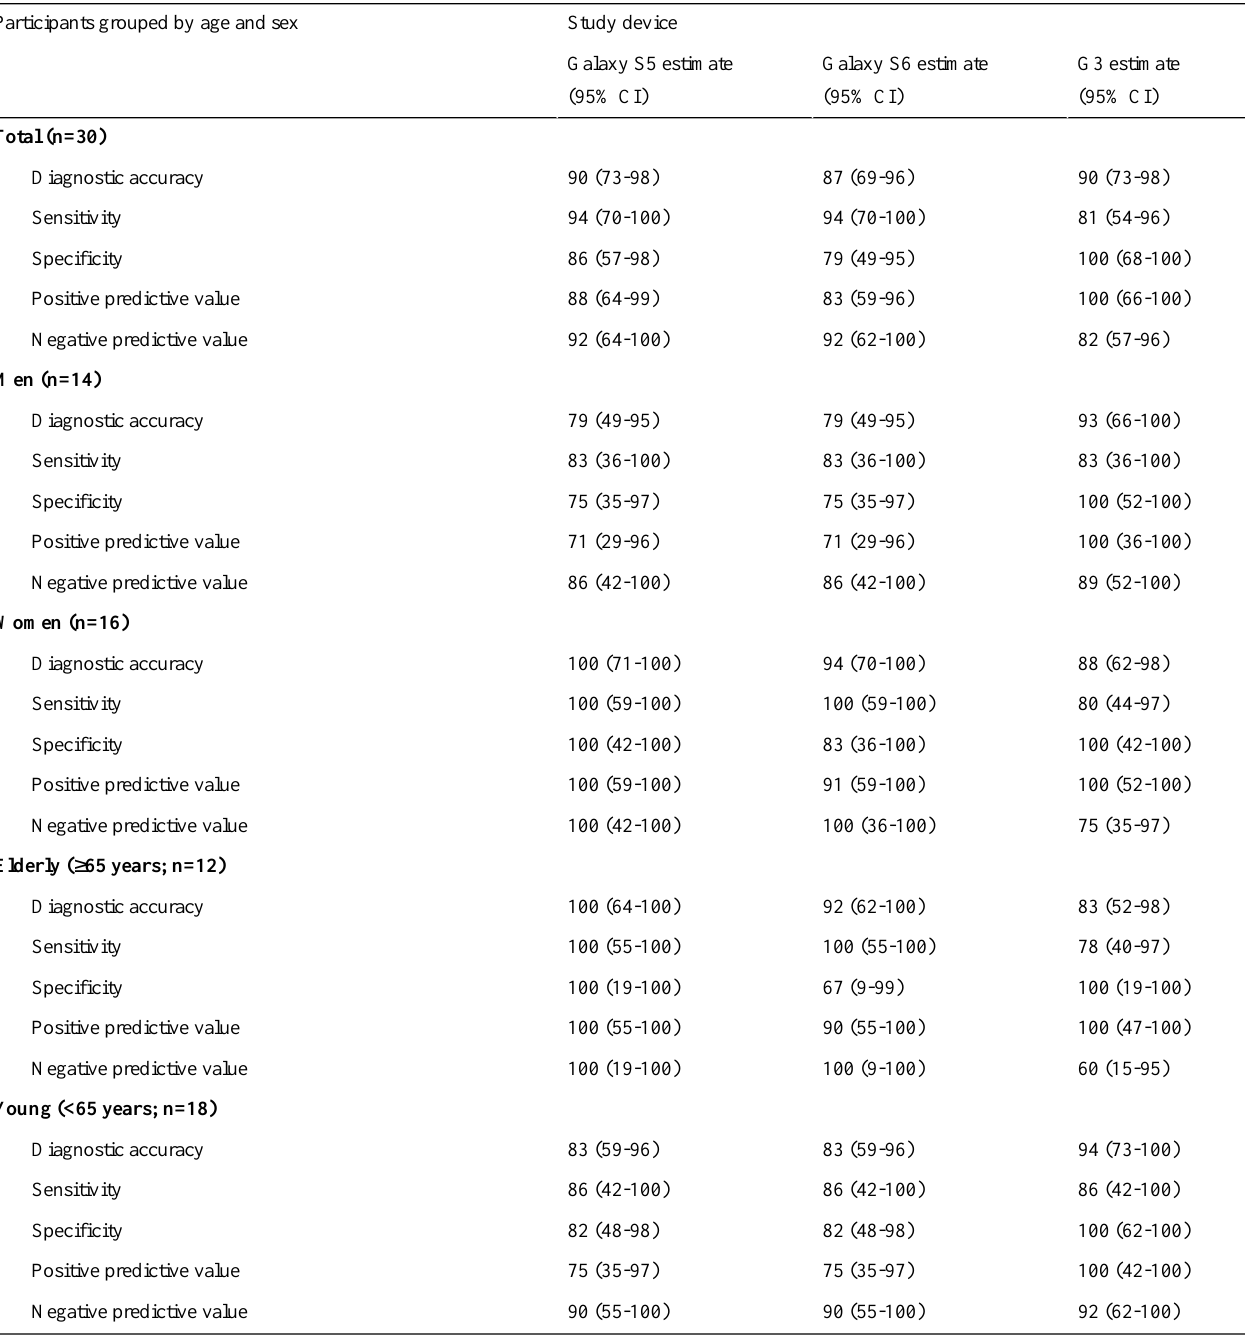
Table 2. Diagnostic performance (%) of each study device.